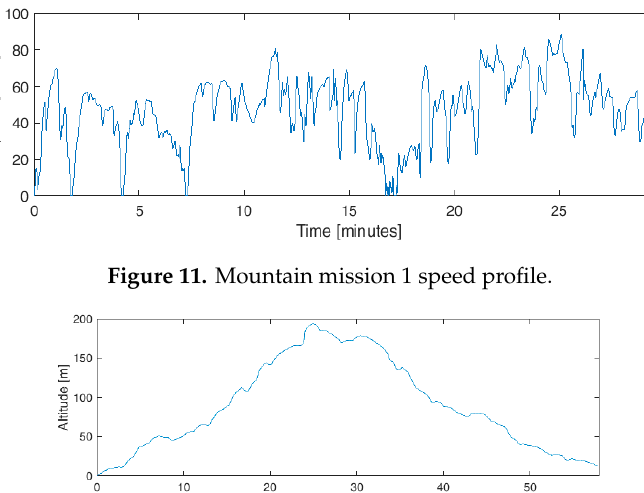
Figure 13. Extra-Urban 2 speed profile. Figure 14. Mountain mission 2 altitude profile.